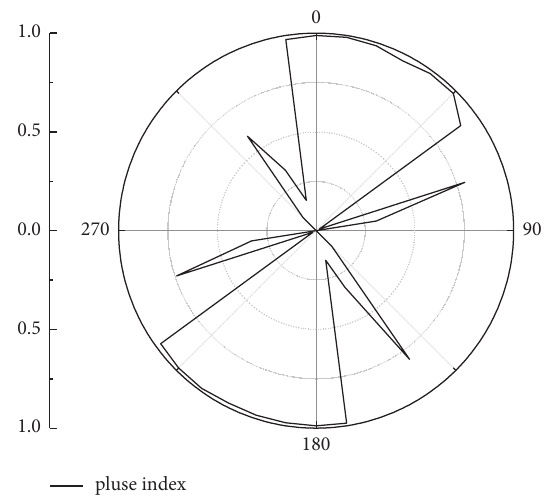
Figure 11: The pulse index.